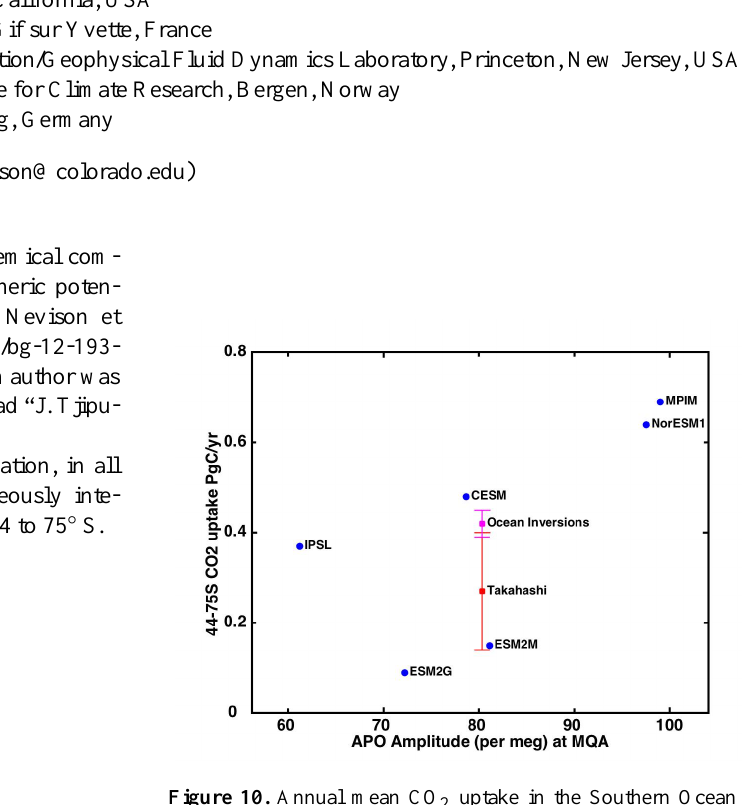
Figure 10. Annual mean CO 2 uptake in the Southern Ocean for 1997–2005 integrated from 44 to 75 ◦ S and plotted vs. mean APO amplitude at Macquarie Island (MQA) over the same period, as predicted by six ESMs. Independent estimates of carbon uptake from ocean inversions and observed p CO 2 databases (Lenton et al., 2013), plotted against the observed APO amplitude at MQA, are shown for